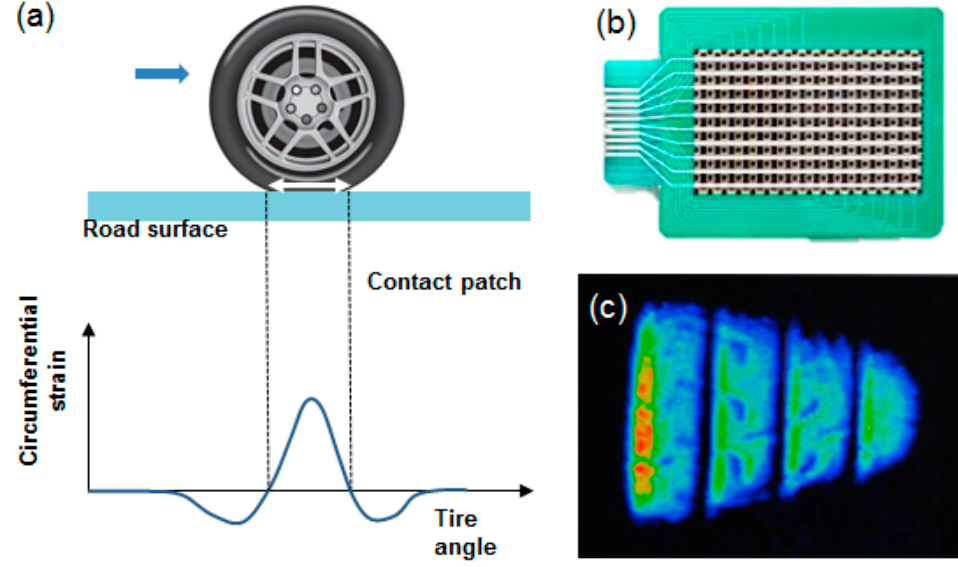
Figure 12. ( a ) Compressive stress distribution on the tire tread, ( b ) matrix array-type force sensor, ( c ) stress (compressive force) distribution on the tire surface.